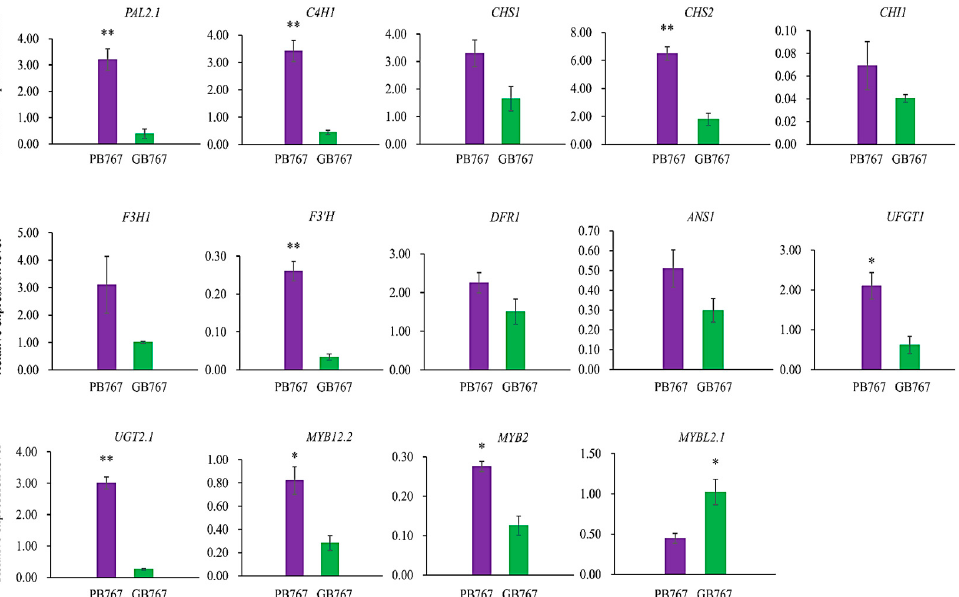
Figure 4. Expression levels of 14 anthocyanin-related genes between GB767 and PB767 by qRT-PCR. The green rectangular bar represents GB767 and the purple rectangular bar represents PB767. The value of the expression level was mean ± standard deviation (SD). * and ** represent significant differences, p < 0.05 and p < 0.01, respectively.